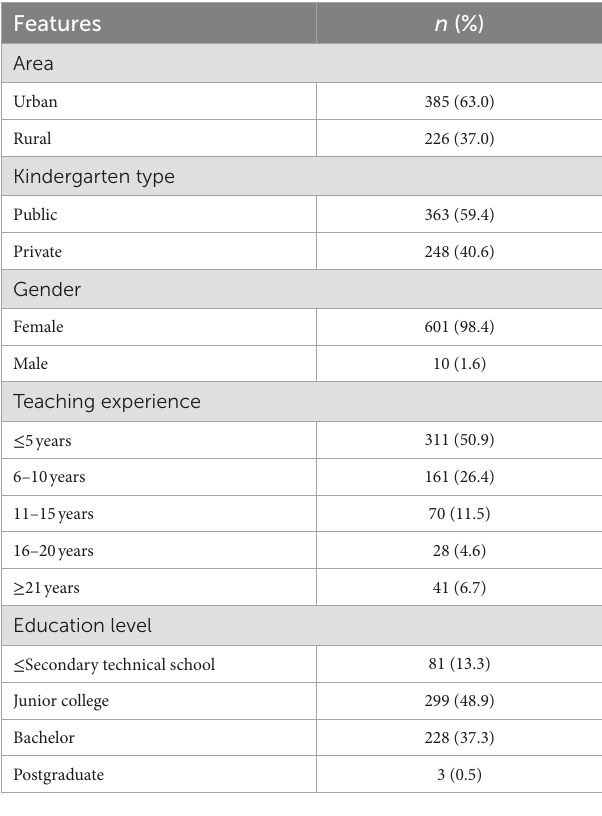
TABLE 1 Demographic information of the sample ( n =